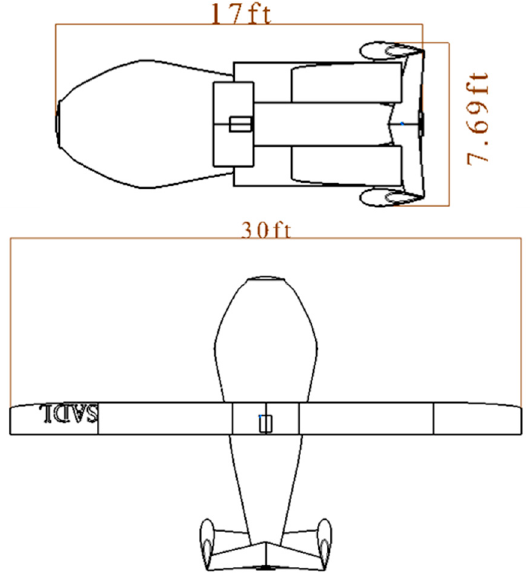
Figure 4. Roadable PAV size dimension from CATIA.